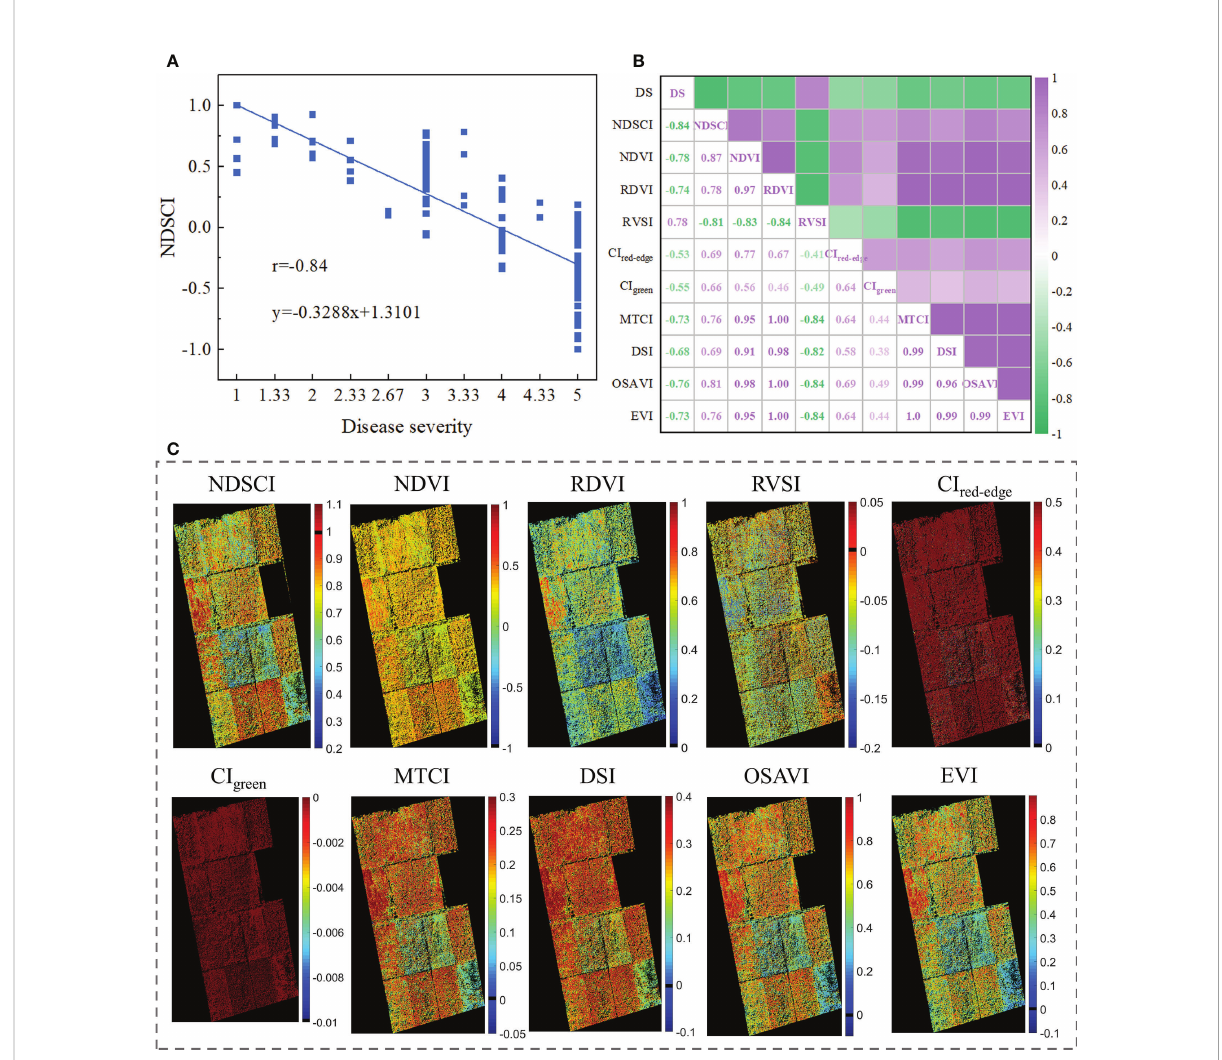
FIGURE 7 Results of NDSCI extension to fi eld data. (A) Scatter plot of the NDSCI of the fi eld. (B) The correlation of the indices and disease severity. (C) Disease severity maps calculated by NDSCI, NDVI, RDVI, RVSI, CI red-edge , CIgreen, MTCI, DSI, OSAVI, and